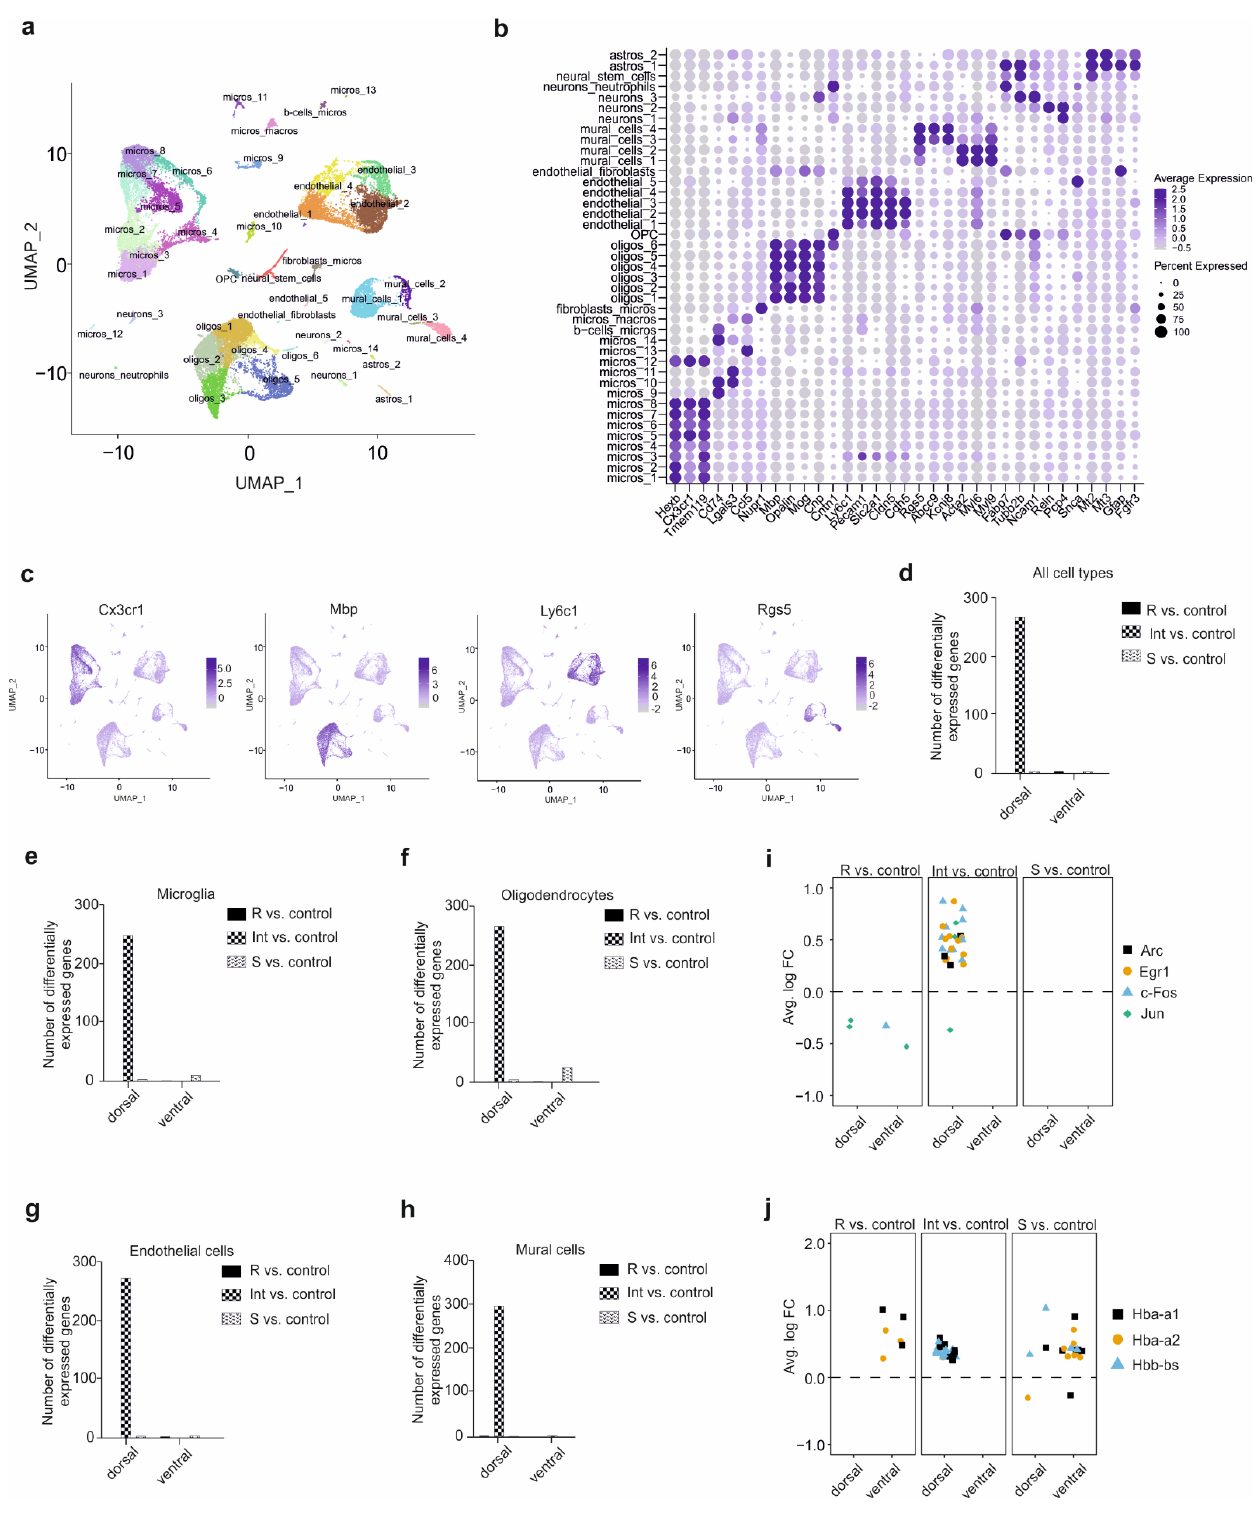
Figure 2. Single-cell analysis identifies different cell types in the different parts of the hippocampus as a specific response to chronic social defeat stress. ( a ) The uniform manifold approximation and projection (UMAP) plot of 29,358 cells in 41 clusters identified after thorough quality control. astros, astrocytes; OPC, oligodendrocytes progenitor cells; oligos, oligodendrocytes; micros, microglia; fi- broblasts/micros, fibroblasts and microglia; micros/macros, microglia/macrophages; b-cells/micros,